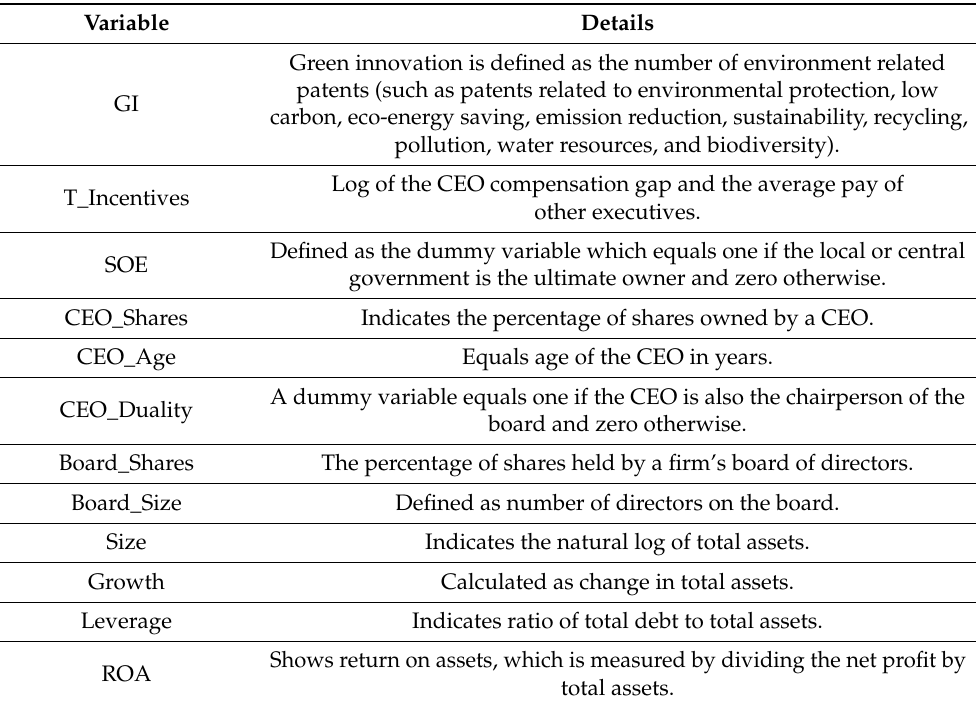
Table 1. Variables definitions and